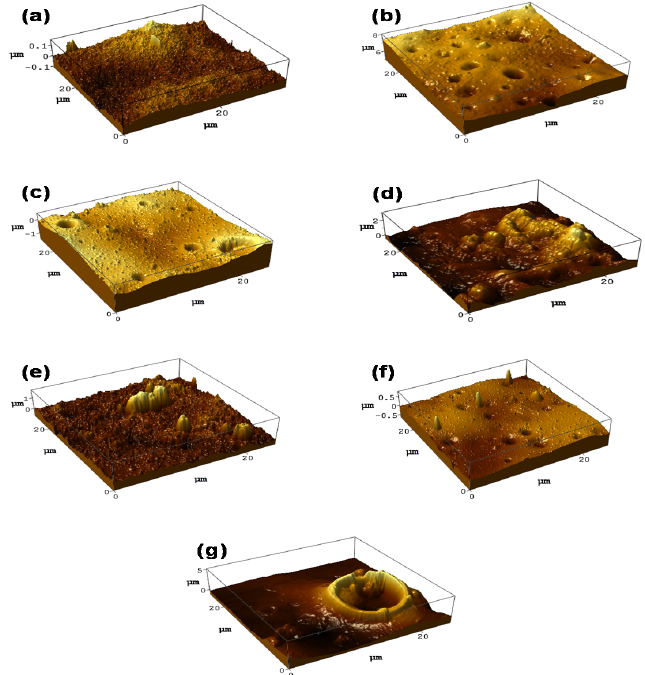
Figure 6. AFM (atomic force microscope) images of PES/LSMM ‐ OGCN membranes: ( a ) PES18wt%; ( b ) PES/LSMM ‐ OGCN0wt%; ( c ) PES/LSMM ‐ OGCN0.5wt%; ( d ) PES/LSMM ‐ OGCN1.0wt%; ( e ) PES/LSMM ‐ OGCN1.5wt%; ( f ) PES/LSMM ‐ OGCN2.0wt%; and ( g ) PES/LSMM ‐ OGCN2.5wt%.